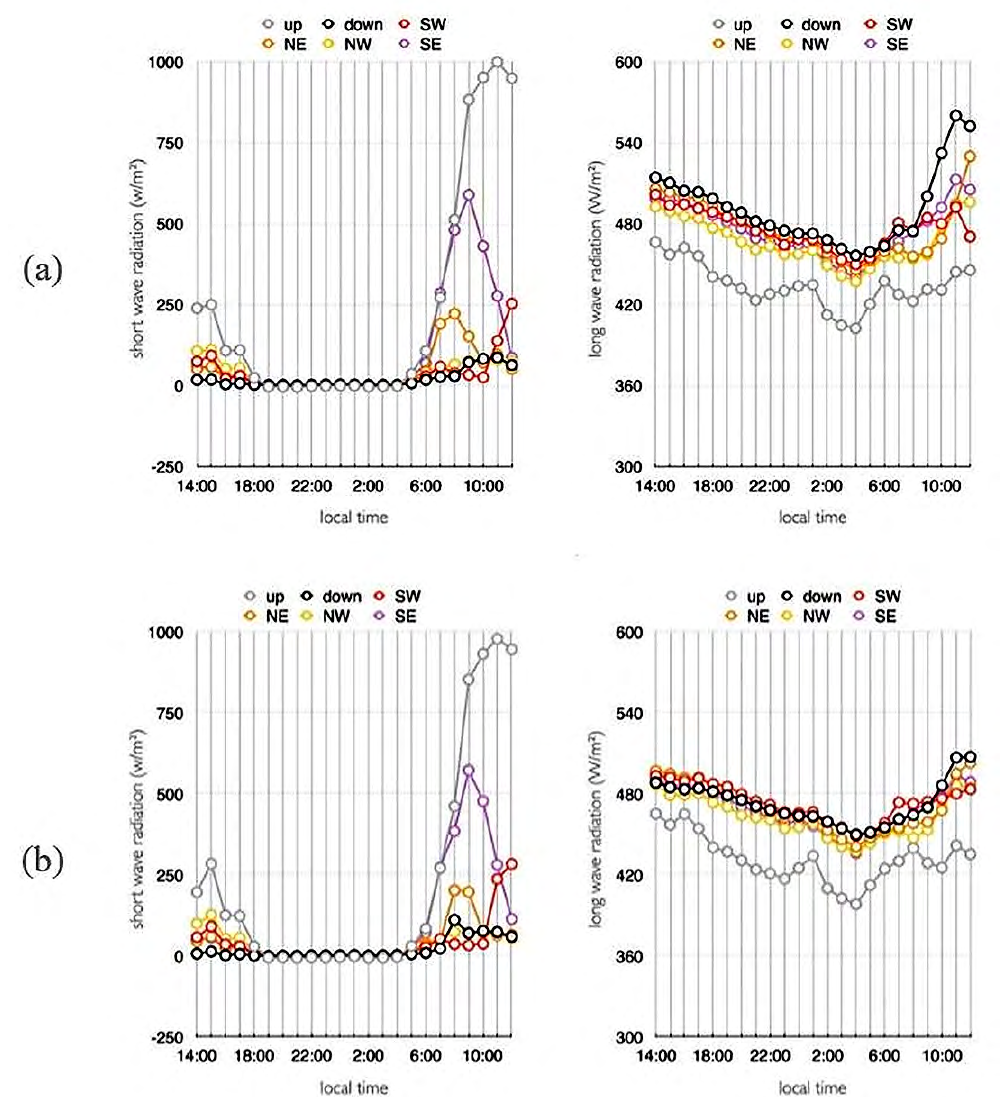
Figure 4. The above-the-concrete-surface (a) and above-the-water-pond (b) measured Short-wave - Sw and Long-wave - Lw radiation (hourly